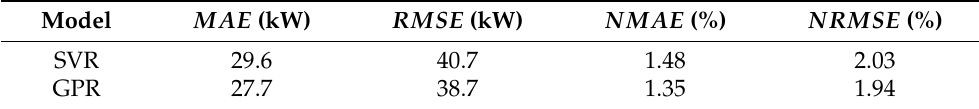
Table 3. Error metrics for the SVR and GPR validation.